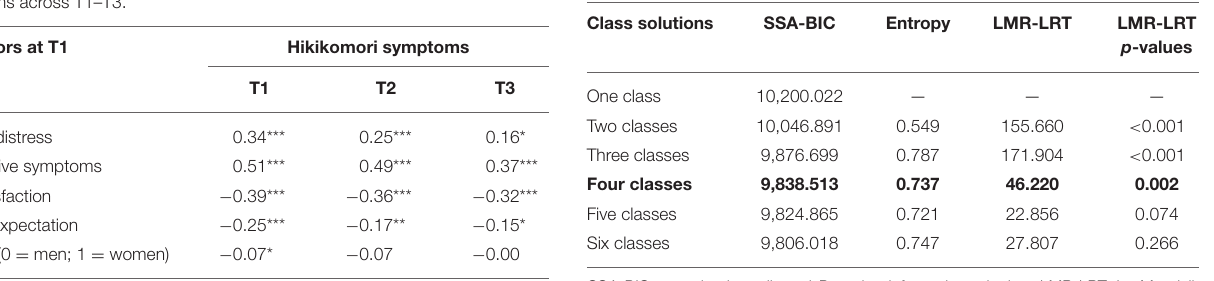
TABLE 4 | Model fits statistics for latent class growth analyses.